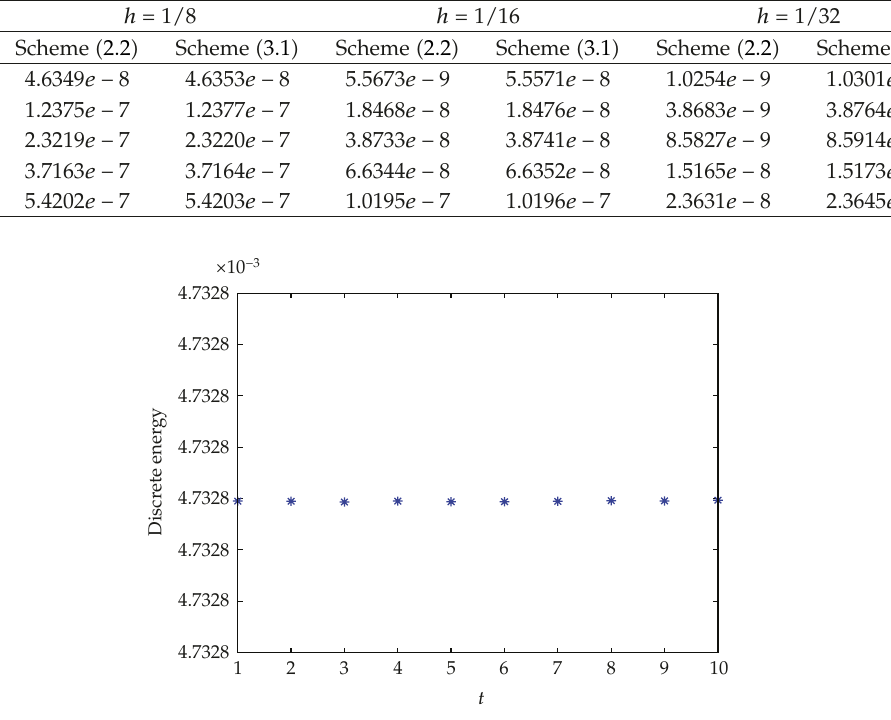
Figure 1: Energy of scheme (cid:5) 2.2 (cid:6) when h (cid:7) 1 / 32 and τ (cid:7) 0 .